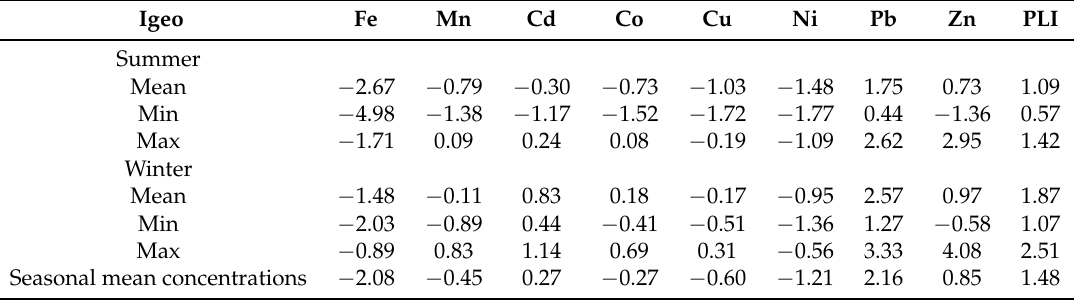
Table 3. Igeo and PLI values for toxic trace metals in Damietta branch sediments during summer and winter seasons.